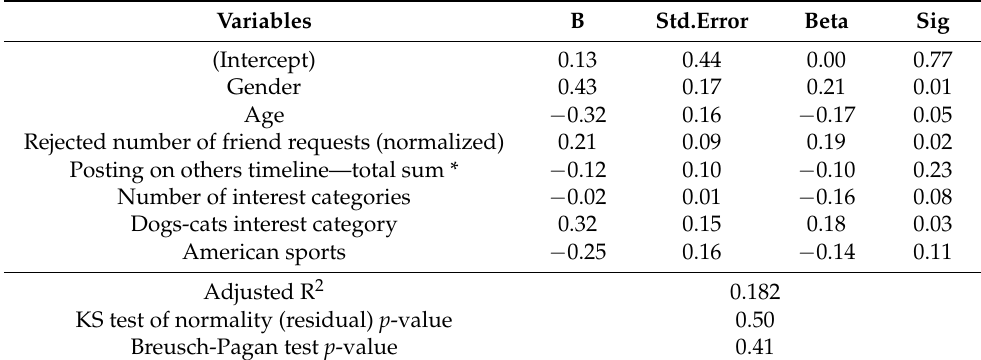
Table 10. Linear Regression model. Dependent variable: Somatic depression.